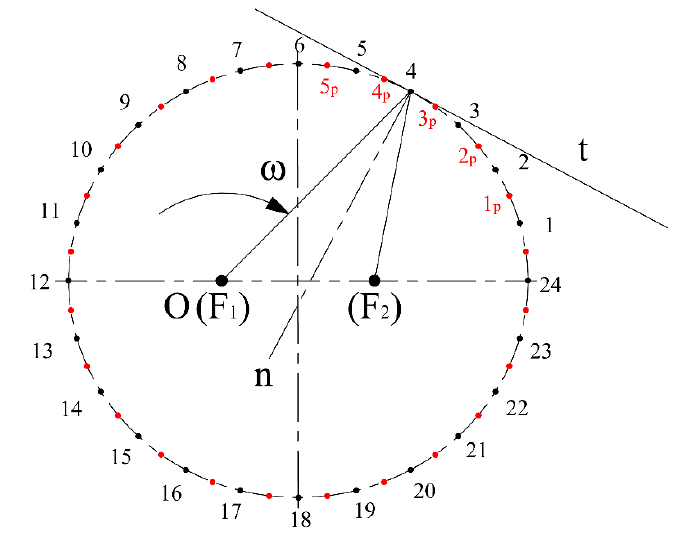
Figure 9. Construction of the tangent “ t ” and normal “ n ” to the pitch ellipse. The second step was the determination of the evolute of the involute, so the geometri- cal locus of the points N i as the last points of mesh (Figure 10).